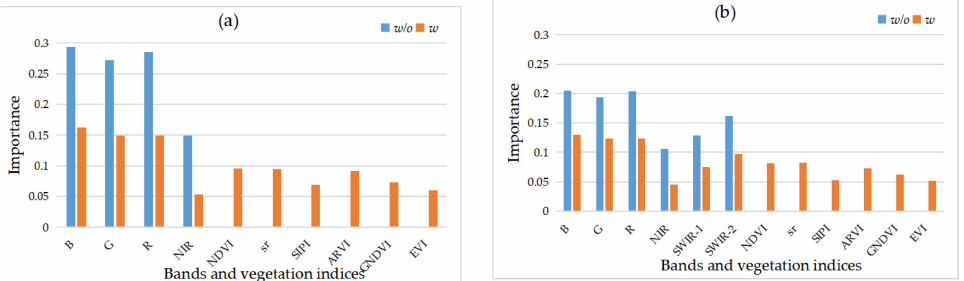
Figure 6. L8 Feature importance in random forest classification. ( a , b ) denote the feature importance of exp1 and exp2, respectively.